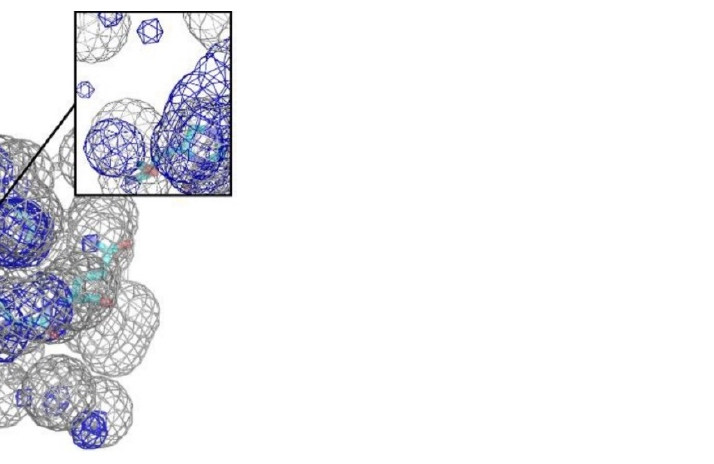
Figure 6. MIF of CaLB computed with the N1 probe (gray) compared with the corresponding cat- alophore of lipases (blue). In the inset: a rotated detail highlighting the area where CaLB differentiates from lipase’s MIFs.